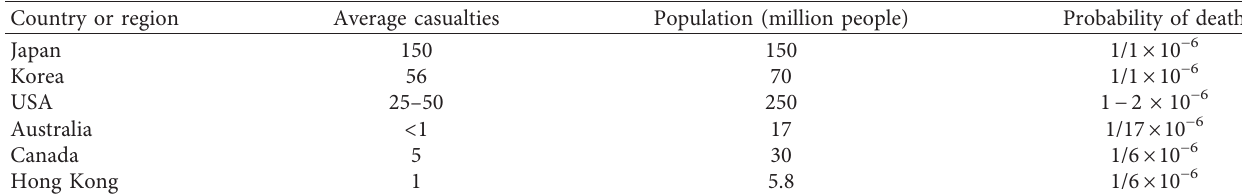
Table 3: Average casualties and annual probability of different countries in recent years [30].